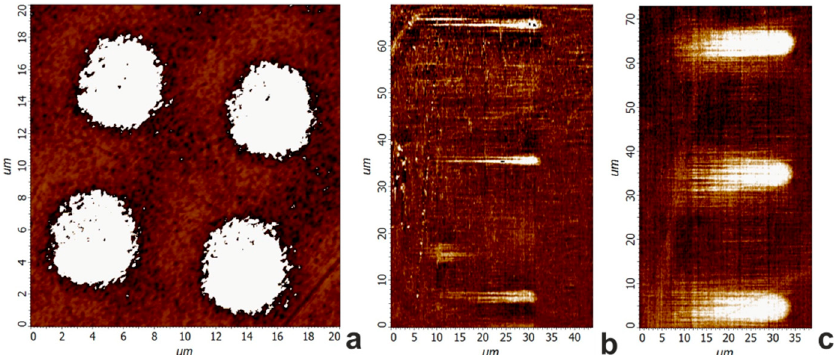
Figure 2. Piezo-response force microscopy (PFM) images of domains written on the polar ( a ) and nonpolar ( b , c ) Sr 0.61 Ba 0.39 Nb 2 O 6 (SBN) surfaces; the irradiation conditions are: U = 25 kV, I = 10 nA; t p = 500 ms ( a , c ) and 5 ms ( b ).